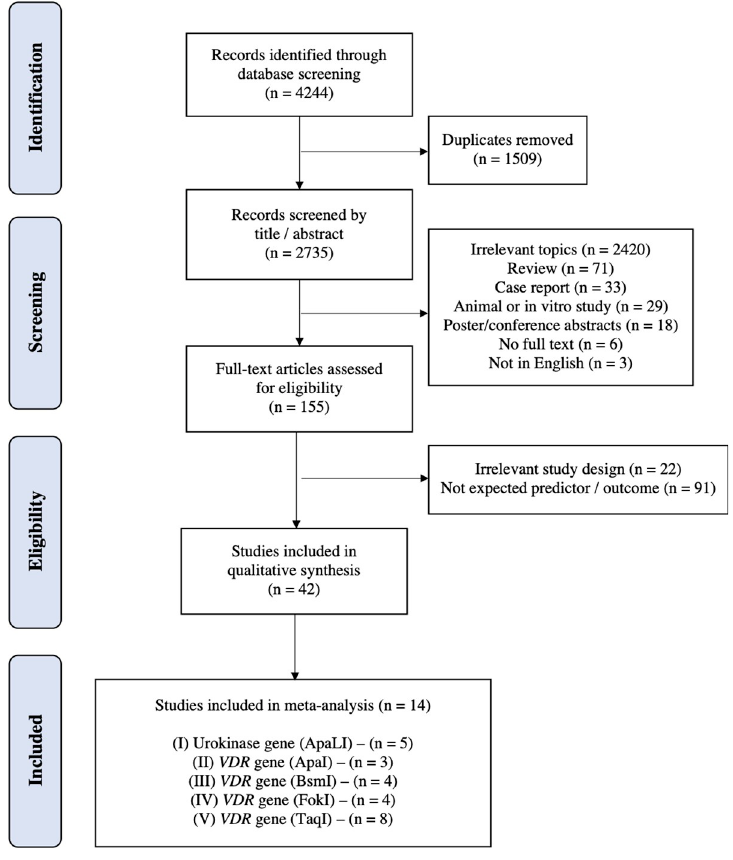
Fig 1. Flow chart of eligible study